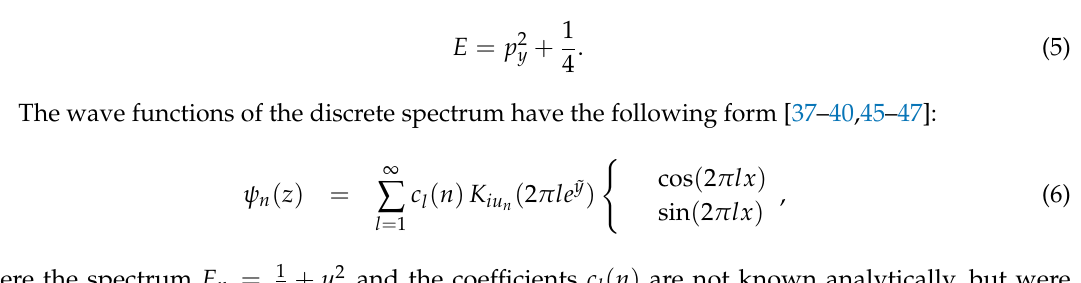
l Figure 2. The continuous energy spectrum is given by the formula